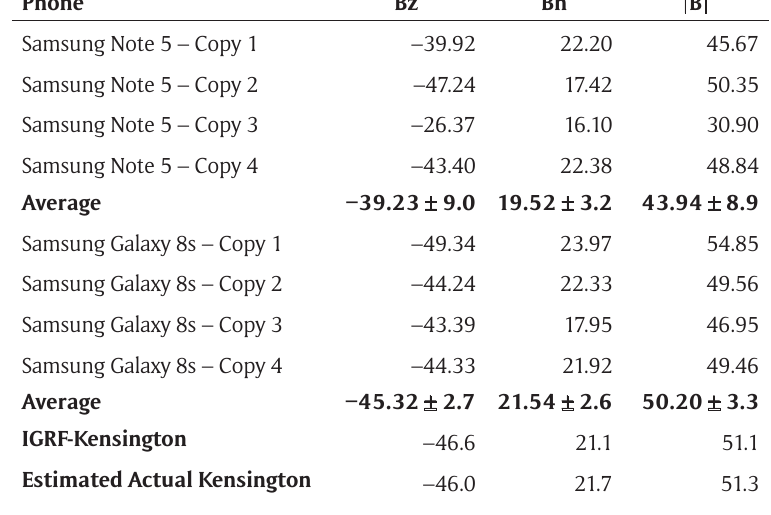
Table 9: Comparison of Samsung magnetic field values in Kensington,